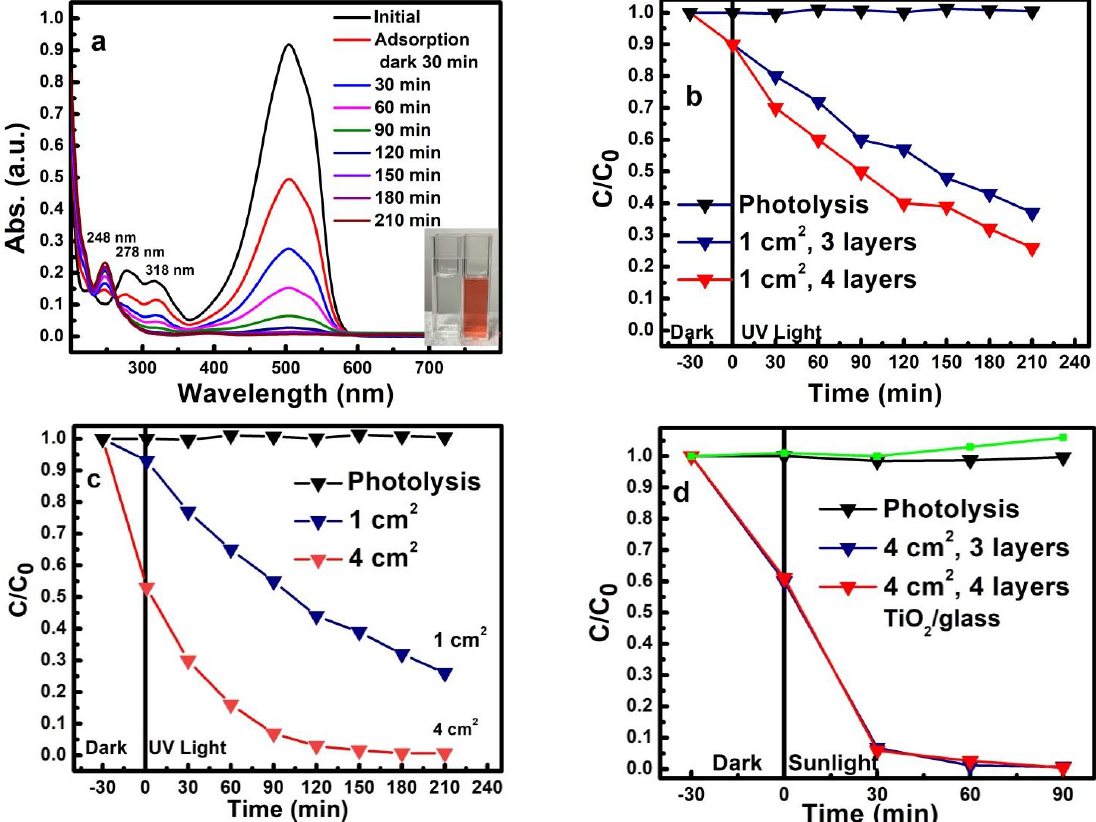
Figure 4. Influence of the photocatalyst quantity/size and radiation source on the photodegradation of methyl orange. ( a ) Absorption spectra exhibiting photodegradation of methyl orange dye under UV irradiation in the presence of 4 cm 2 TiO 2 /3D-GF/Ni photocatalyst (inset: the photograph of the dye solution before (orange) and after 210 min (colorless) of UV exposure); ( b ) photodegradation un- der UV exposure of 1 cm 2 TiO 2 /3D-GF/Ni with 3 and 4 TiO 2 deposition cycles; ( c ) photodegradation under UV exposure of 1 and 4 cm 2 TiO 2 /3D-GF/Ni with 4 TiO 2 deposition cycles; ( d ) photodegra- dation under simulated sunlight exposure of 4 cm 2 TiO 2 /3D-GF/Ni with 3 and 4 TiO 2 deposition cycles, as well as TiO 2 film on a glass